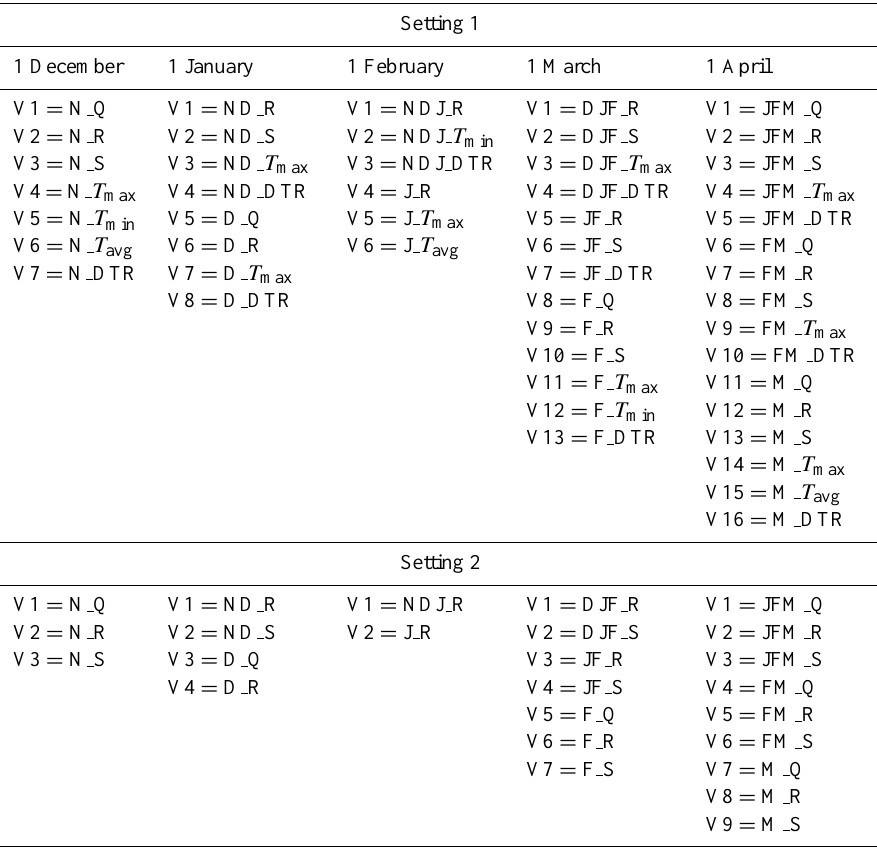
Table 4. Names of different variables considered in best-subset selection in Fig. 5.